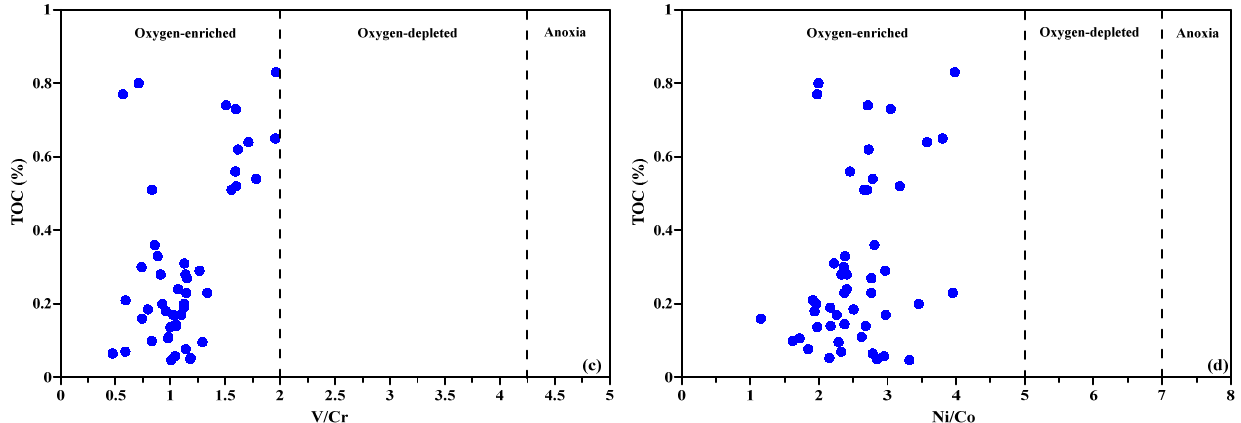
Figure 5. Paleoredox discrimination of the mudstones in the Meitan Formation. TOC = Total organic carbon. ( a ) relationship between Th/U and TOC; ( b ) relationship between V/(V +Ni) and TOC ( c ): relationshio between V/Cr and TOC ( d ): relationship between Ni/Co and TOC. Table 4. Paleoredox evaluation index.